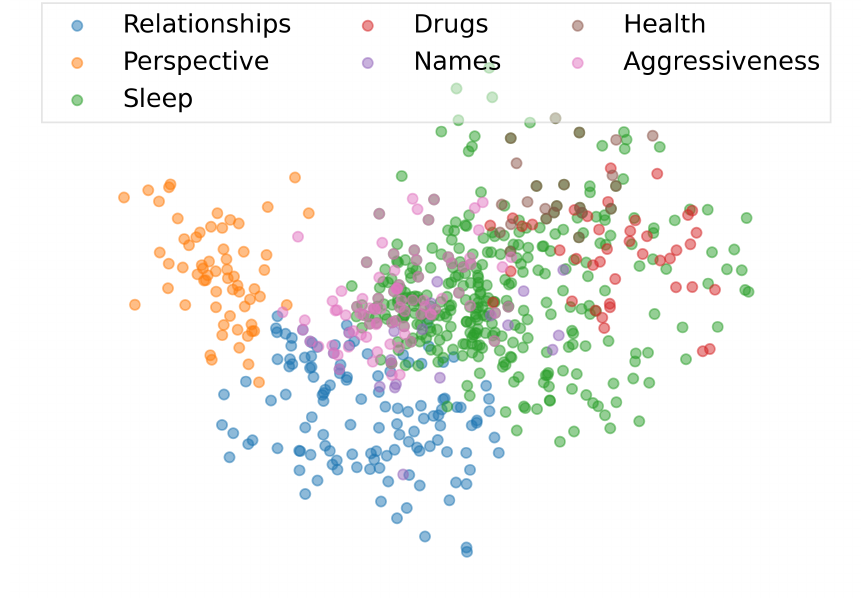
Figure 6. Clusters of word embeddings by topic, depicted using principal component analysis